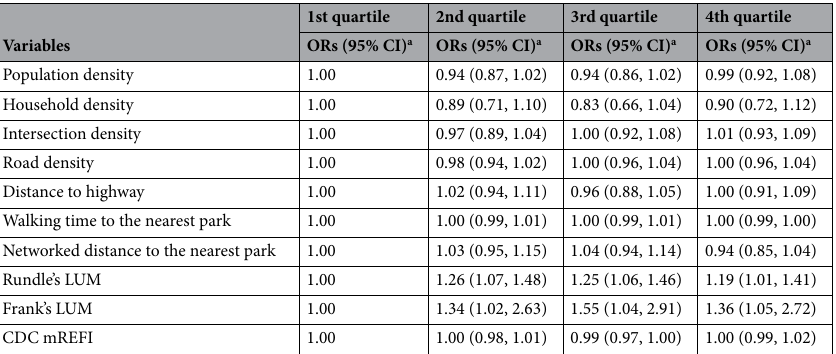
Table 3. Multinominal logistic regression to estimate the association between individual built environment variables and telomere length. a Adjusted by age, sex, BMI, physical activity, health insurance, born place, acculturation, and census